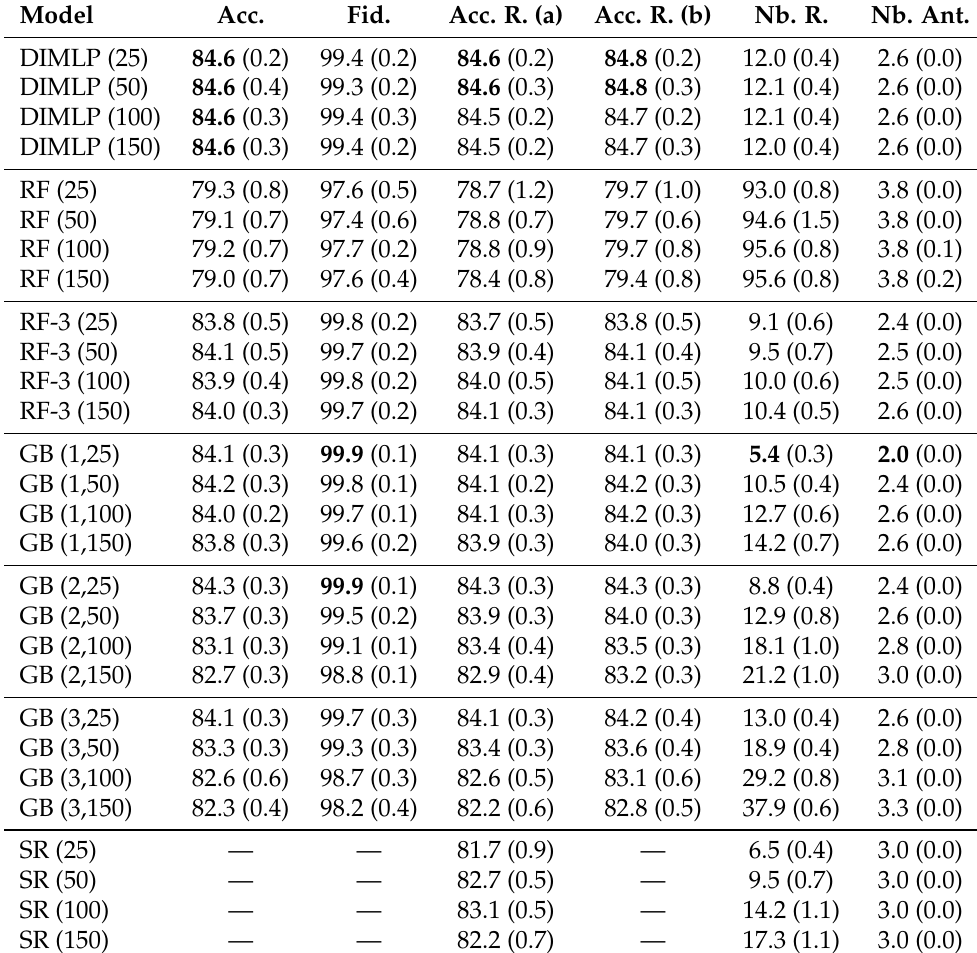
Table 7. Average results obtained on the “Mammographic” dataset. For each column, the highest average accuracy or average fidelity is represented in bold, along with the lowest average number of rules or average number of antecedents.